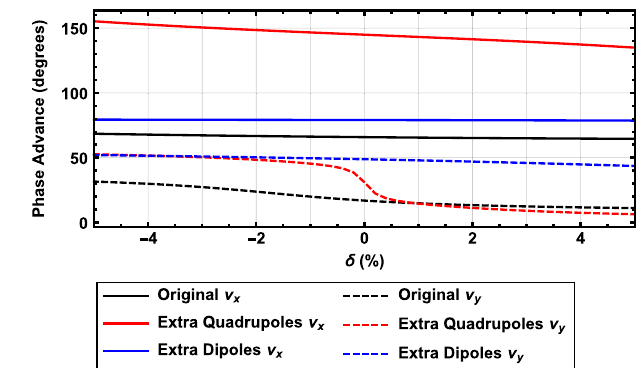
FIG. 10. Phase advance dependence on δ at the end of BC1 for the original lattice (black), extra quadrupoles (red) and extra dipole solutions (blue).